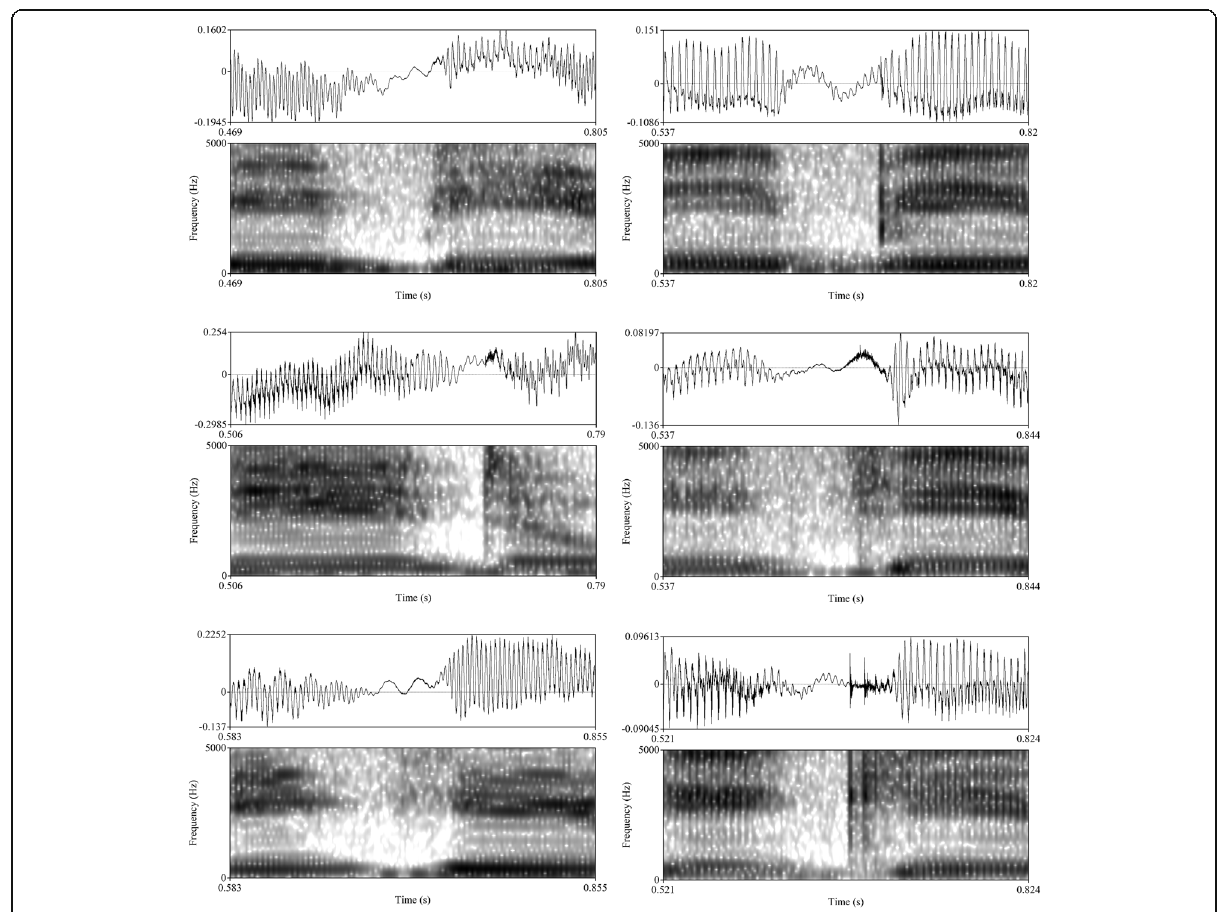
Fig. 8 Waveforms and spectrograms of acoustic data collected by Pape and Jesus [40] for a German (left) and a Portuguese (right) female speaker: speech signals corresponding to [ibi] (top), [idi] (middle) and [i ɡ i] (bottom) sequences from the previously recorded [40] CVCV (consonant, vowel, consonant, vowel) items in the context of a frame sentence. The consonant and vowel were pairwise identical (e.g., <bibi>, <didi> and <gigi>), sentence stress was on the CVCV pseudoword, and lexical stress was set to the first syllable of the CVCV pseudoword